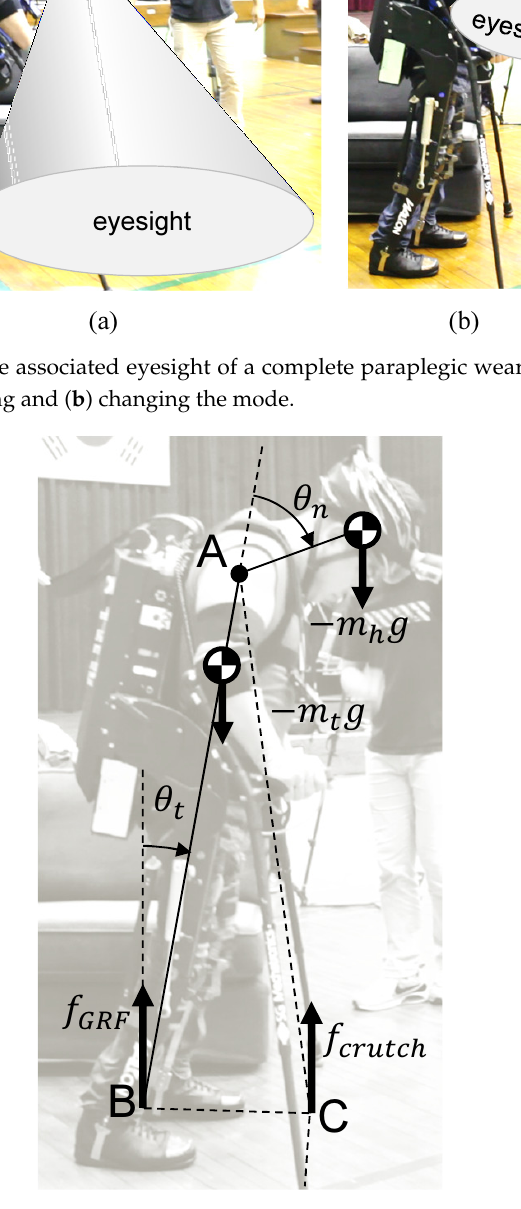
Figure 4. Posture analysis of a person with the WalkON Suit while changing the